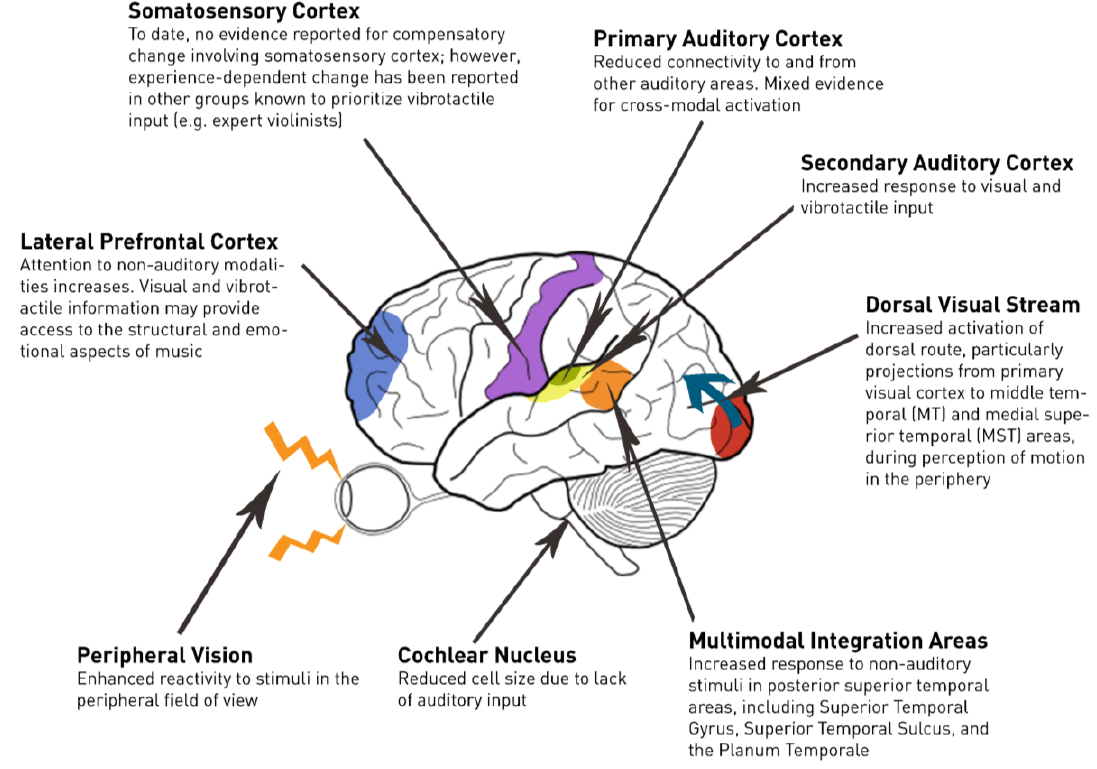
Figure 1. Changes in the deaf brain relevant to music